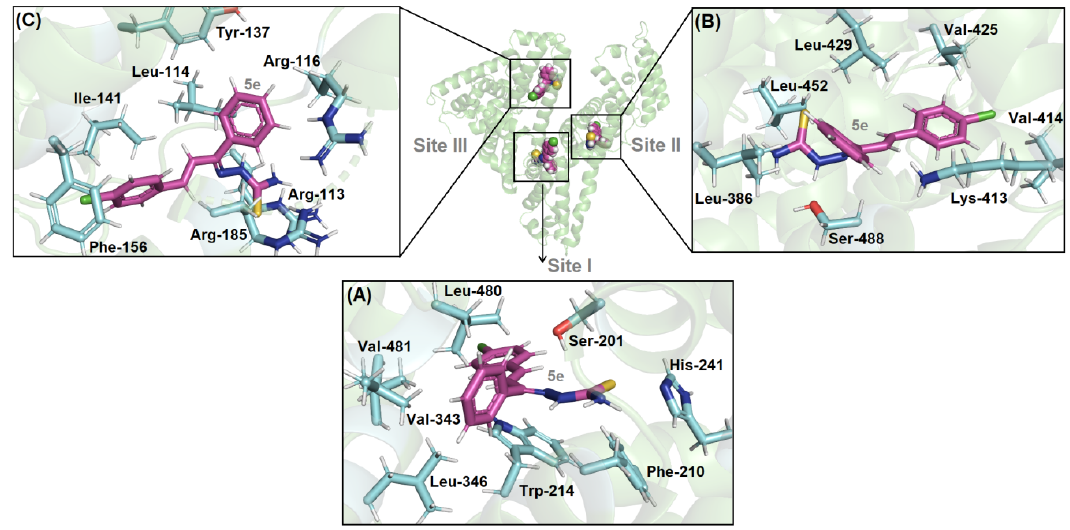
Figure 8. Best docking pose (ChemPLP function) for the interaction HSA: 5e inside three main binding pockets: ( A ) site I, ( B ) site II and ( C ) site III. Selected amino acid residues are represented as stick in blue, while 5e structure is represented in pink. Hydrogen, oxygen, nitrogen, sulfur and chloro atoms are represented in white, red, dark blue, yellow and green,